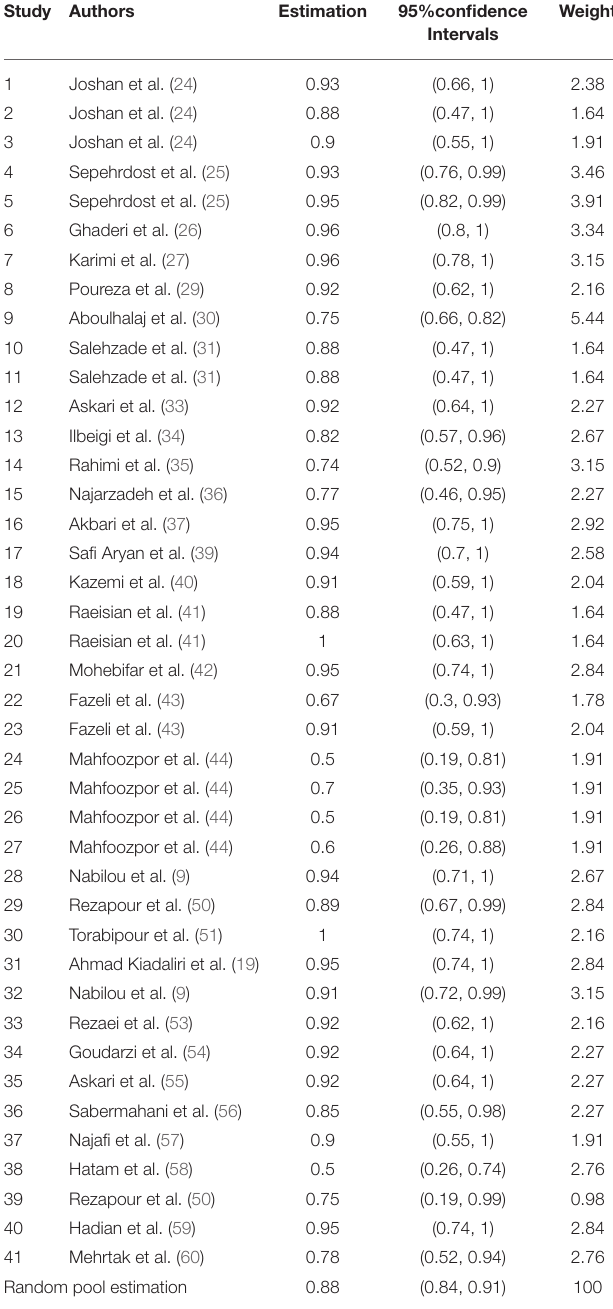
TABLE 5 | The results of pool estimation for economies of scale efficiency among Iranian hospitals. Study